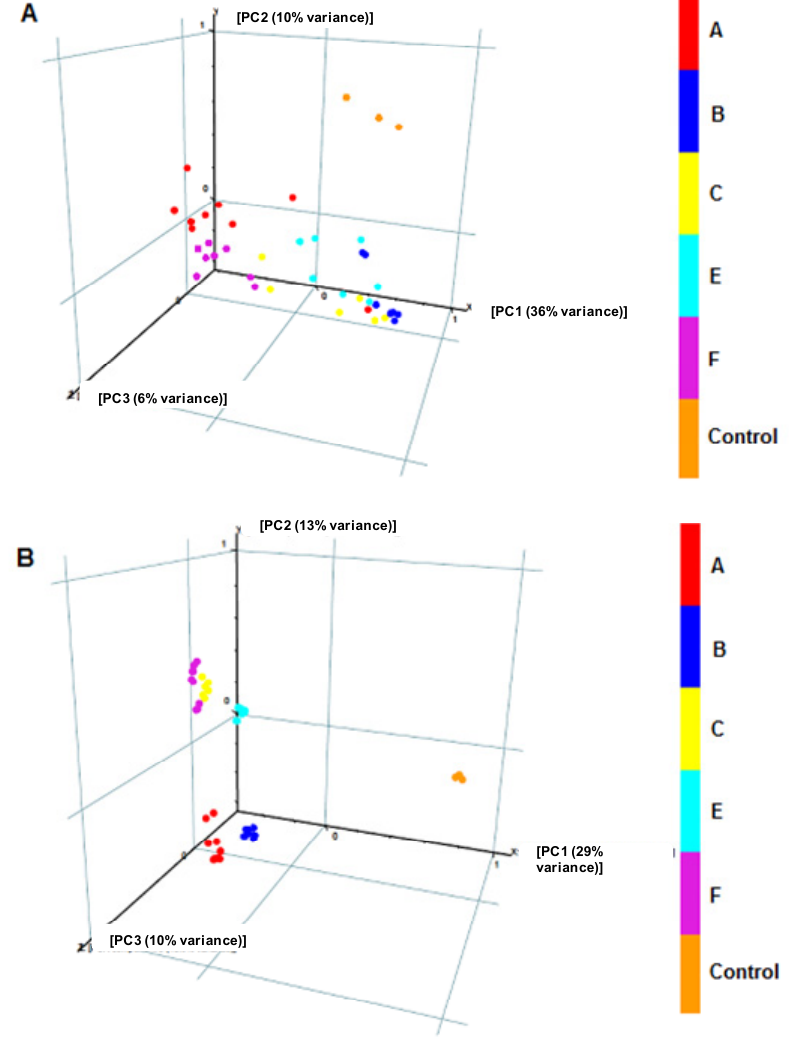
Figure 8. GC-MS extracellular metabolite data from samples of Acidovorax temperans (strains A-E). ( A ) samples derivatized by silylation reaction (TMS), and ( B ) samples derivatized by alkylation reaction (MCF). Principal component analysis (PCA) projection of extracellular metabolite data obtained from all detected compounds (deconvoluted raw chromatogram) from approximately 48 samples into a 3D space reveals distinct clustering of 5 data classes only in (B). Each sample (dots) was normalized by internal standard (d4-alanine) and only MS fragments related to metabolites with statistical significance (ANOVA) were considered. Control, uninoculated culture